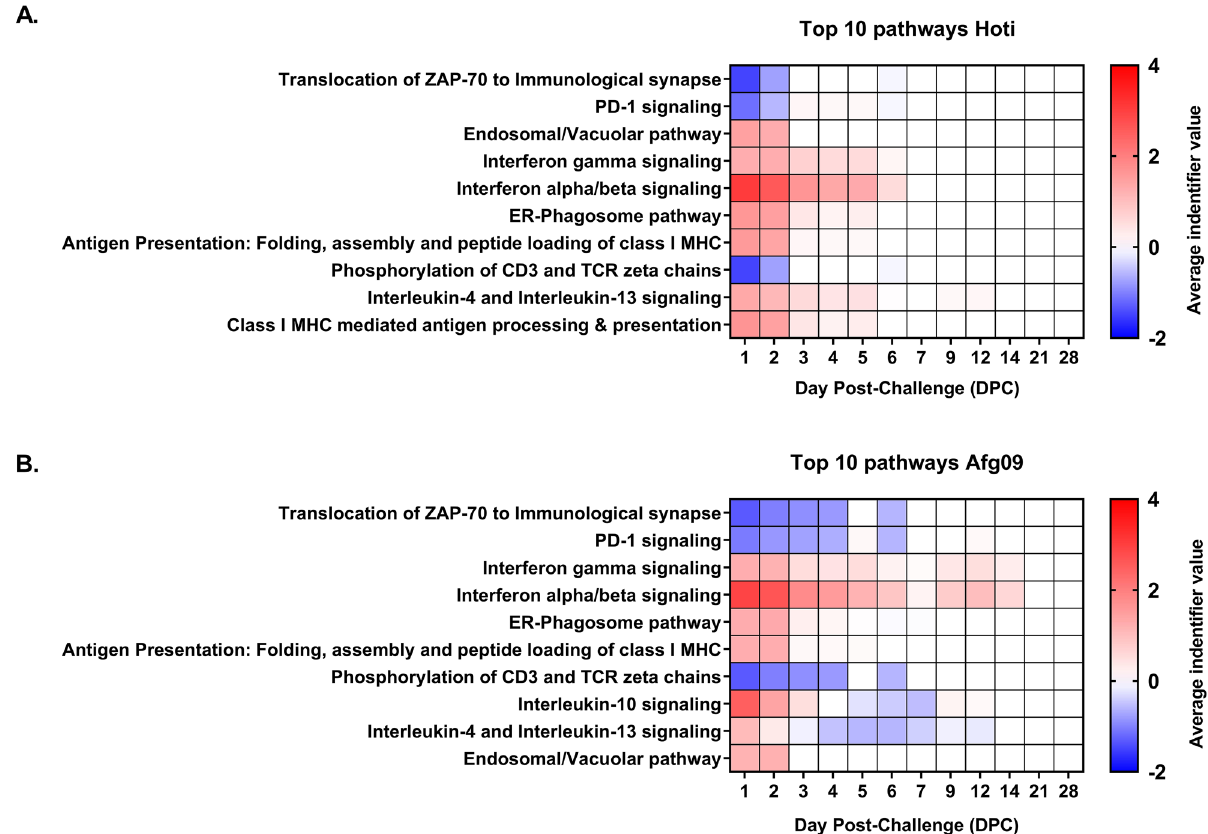
Figure 3. Pathway analysis of DEGs using Reactome. Top 10 pathways for Hoti ( A ) and Afg09 ( B ) are shown here ranked by average identifier value, a consensus of the fold changes of the genes present in the specific pathway. All pathways shown had p-values of 1.11 × 10 –16